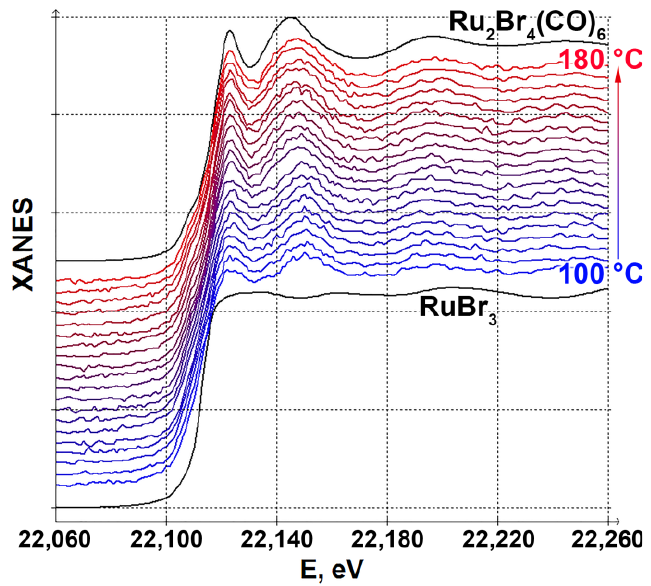
Figure 5. Ru K -edge XANES spectra acquired during the heating of the Bu 4 PBr + RuBr 3 system under 5 bar of CO + 20 bar of H 2 . The top and bottom black lines are the reference spectra of Ru 2 Br 4 (CO) 6 and RuBr 3 ,